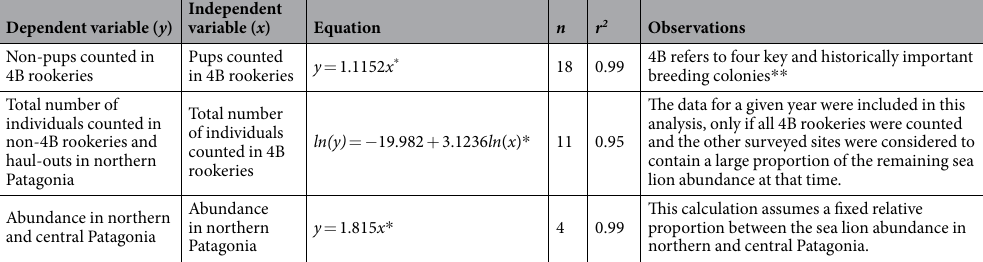
Table 4. Correction factors used to reconstruct the South American sea lion Otaria flavescens population abundance in northern and central Patagonia. * Regressions were carefully examined, and their residuals evaluated to detect departures from the statistical assumptions. ** 4B are Punta Norte, Punta Buenos Aires, Punta Pirámide, and Punta León